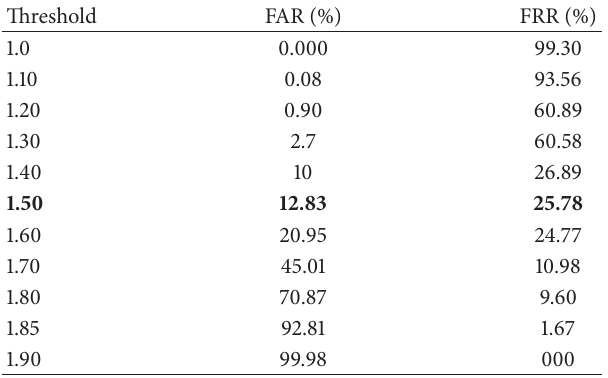
Table 5: Best FAR, FRR, and corresponding threshold for Experiment 4.